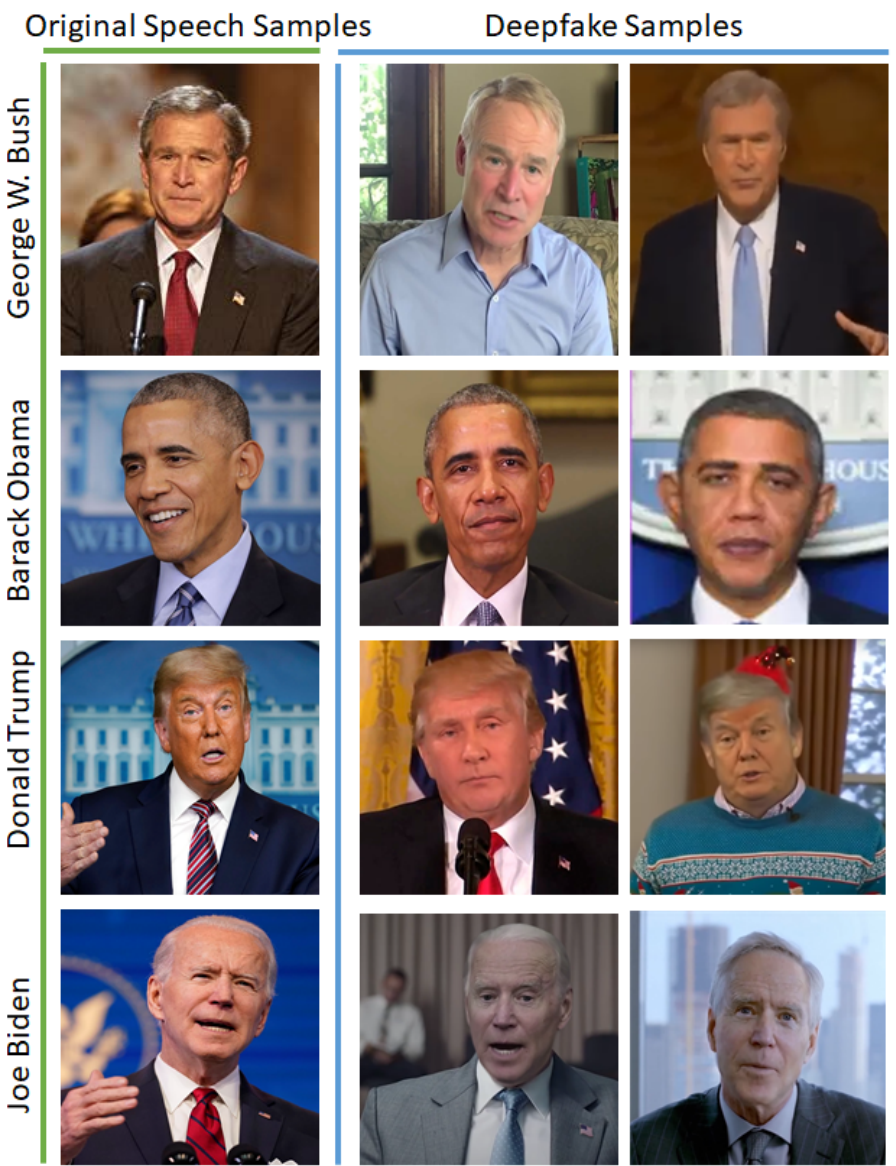
Figure 4. Dataset Sample: The dataset build for the proposed experiments is composed of four recent presidents of the United States. We did not extract videos of earlier presidents due to the unavailability (very few) deepfake